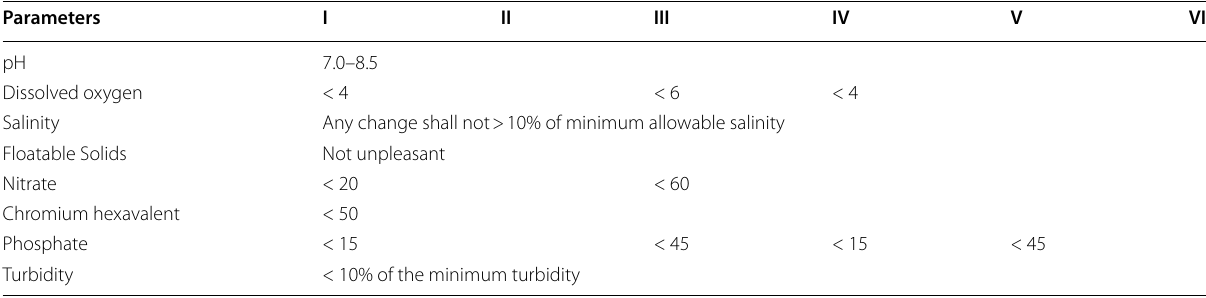
Table 3 Marine water quality standard (Thailand National Environment Board)